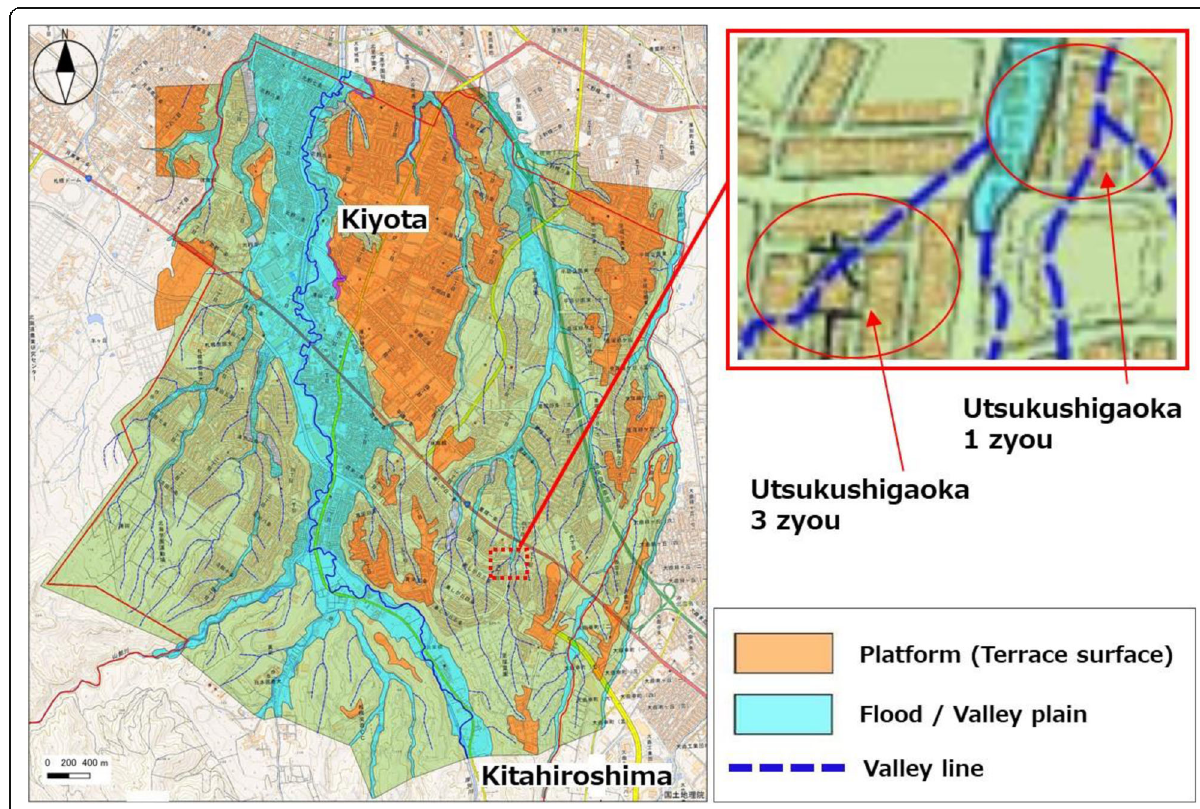
Fig. 8 The old topographical map of Kiyota ward, Sapporo city in 1961(Geographical Survey Institute